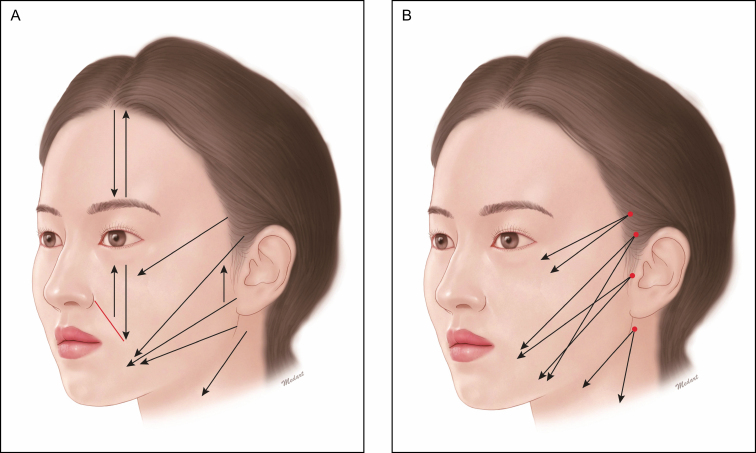
Use of a non-fixation type, bidirectional cog thread. (A) Also known as a floating threadlift, the Mint Lift Fine is advantageous in that there are no limitations in the entry site. (B) The entry point may be located in a limited scope because of the possible occurrence of dimpling.